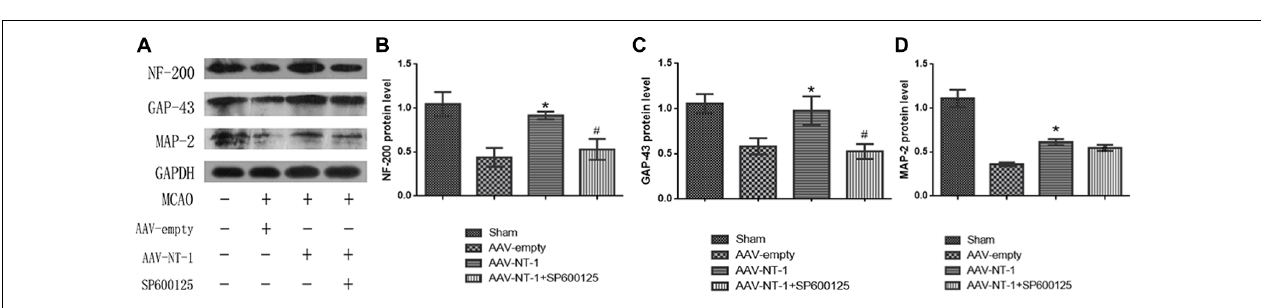
FIGURE 8 | Effects of Netrin-1 overexpression and/or JNK inhibition on the axonal regeneration after the MCAO. (A) The representative images of western-blot analysis for NF-200, GAP-43 and MAP-2. Rats in each group were sacrificed at Day 14 after the MCAO. (B) Western-blot analysis of NF-200 ( n = 3), ∗ p < 0.01, as compared with the AAV-empty group, # p < 0.05, as compared with the AAV-empty group. (C) Western-blot analysis of GAP-43 ( n = 3), ∗ p < 0.05, as compared with the AAV-empty group, # p < 0.01, as compared with the AAV-NT-1 group. (D) Western-blot analysis of MAP-2 ( n = 3), ∗ p < 0.05, as compared with the AAV-empty